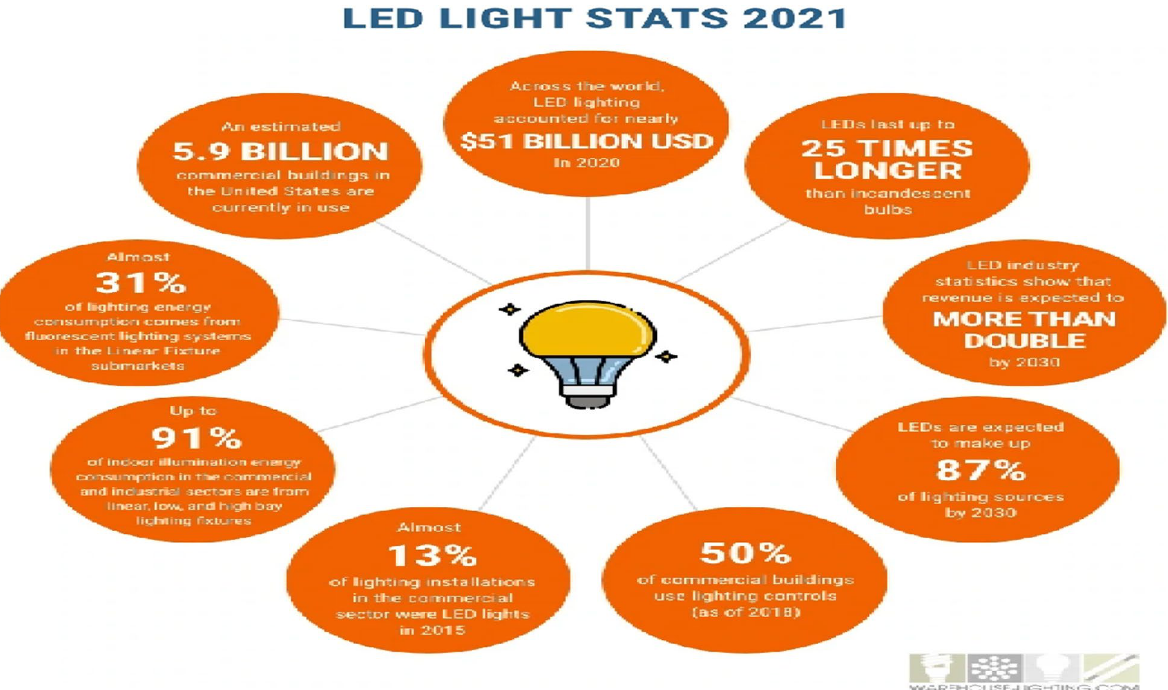
Fig. 12 Lead lighting share in industry (https:// www. wareh ouse- light ing. com/ blogs/ light ing- blog/ led- light ing- stati